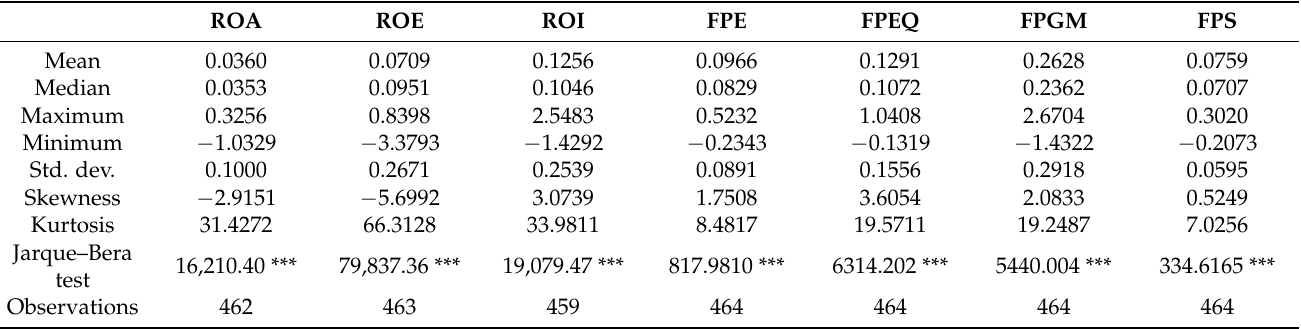
Table 2. Descriptive statistics for gas companies.